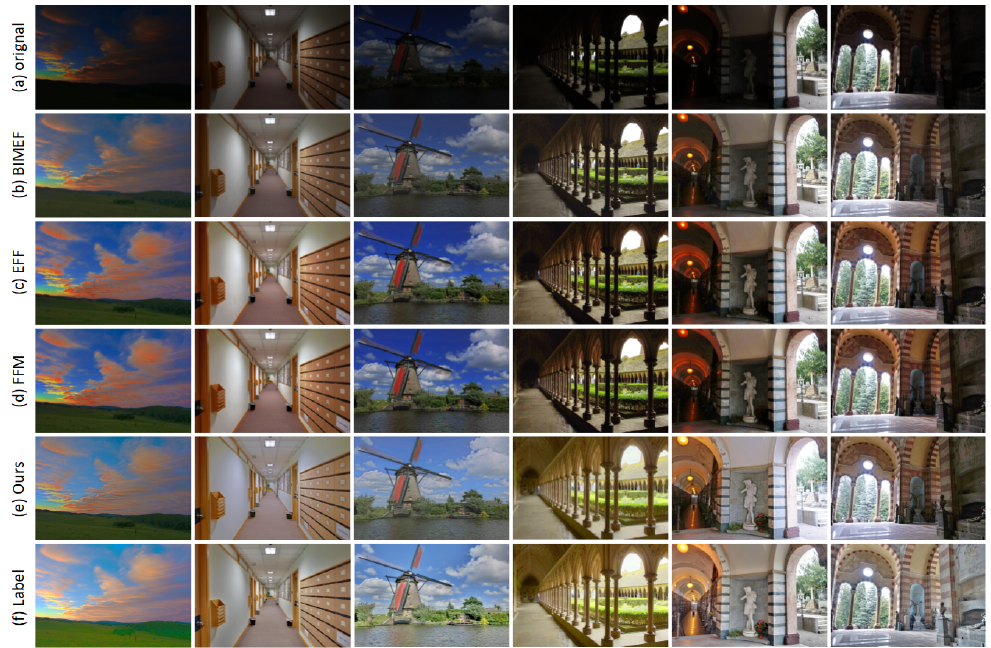
Figure 6. Example of comparison with a low-light image enhancement method based on exposure image fusion on the SICE (Single Image Contrast Enhancer) [33]